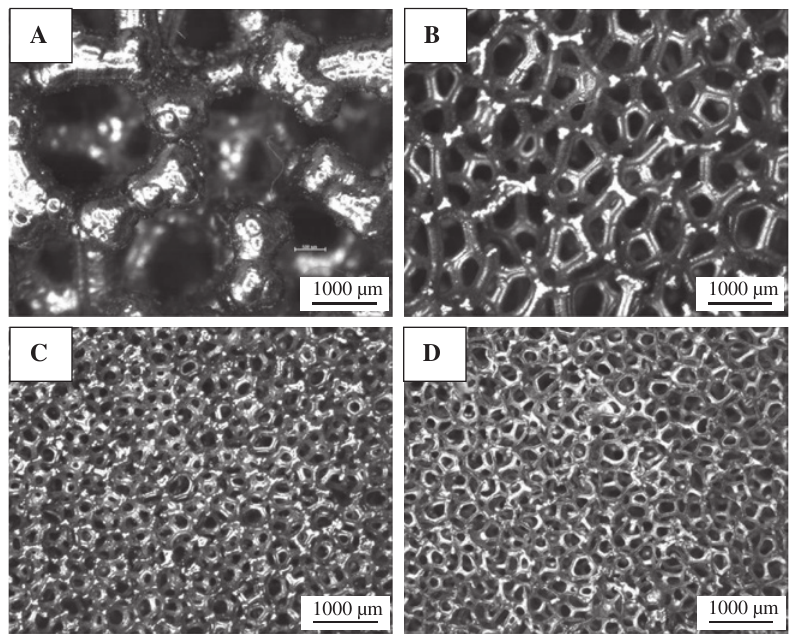
Figure 1: Ni foams used in the work: (A) 25 PPI, (B) 50 PPI, (C) 100 PPI-1, and (D) 100 PPI-2.